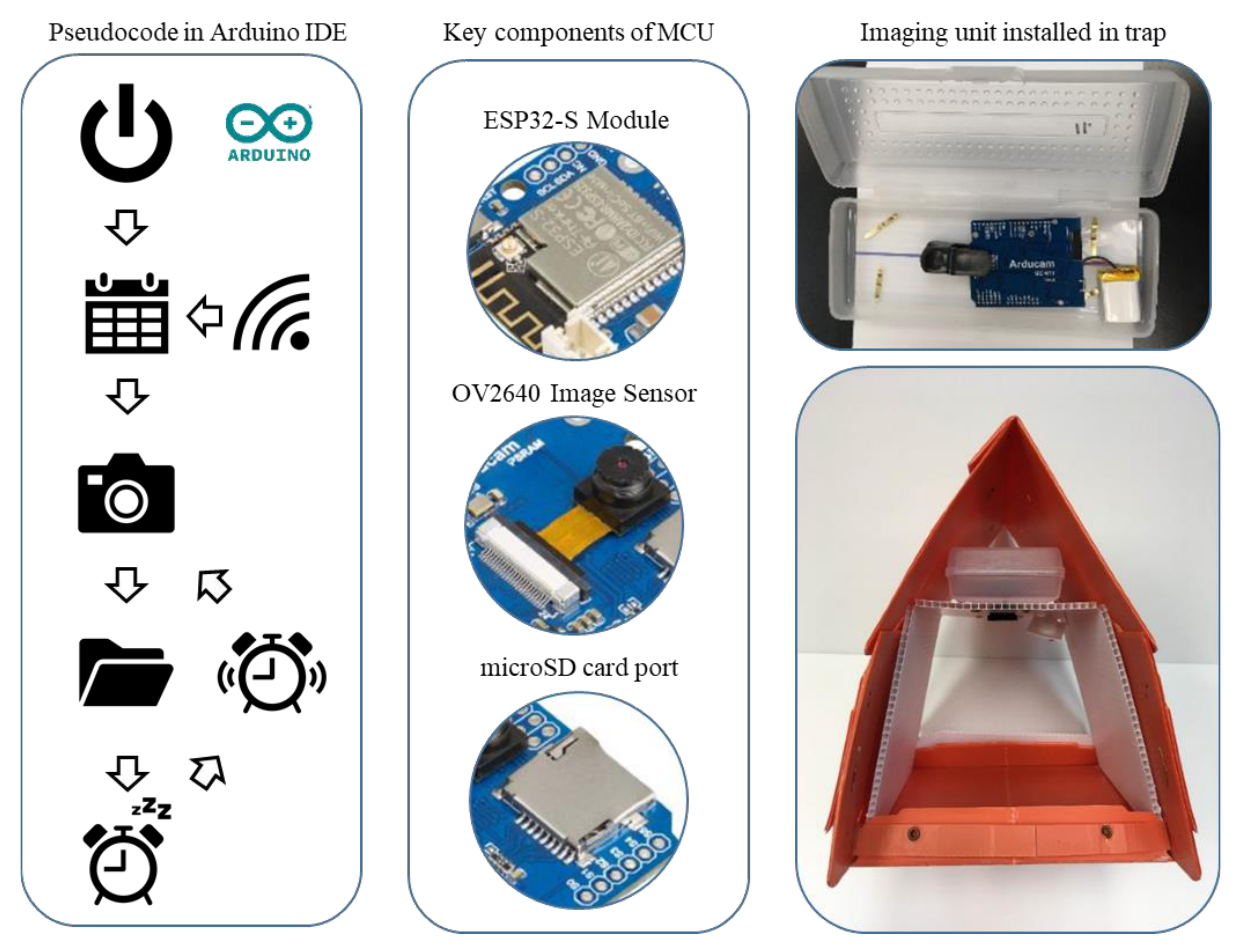
Figure 2. Plug-in RGB imaging system installed in a standard delta trap with inserts illustrating MCU and imager.